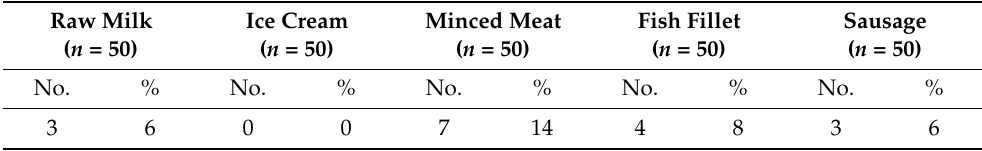
Table 2. Prevalence of Listeria monocytogenes in food products.